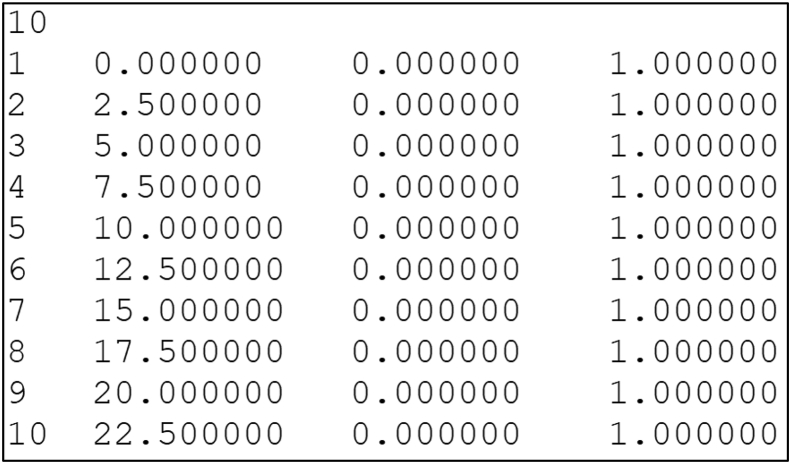
A data file corresponding to Table 1.